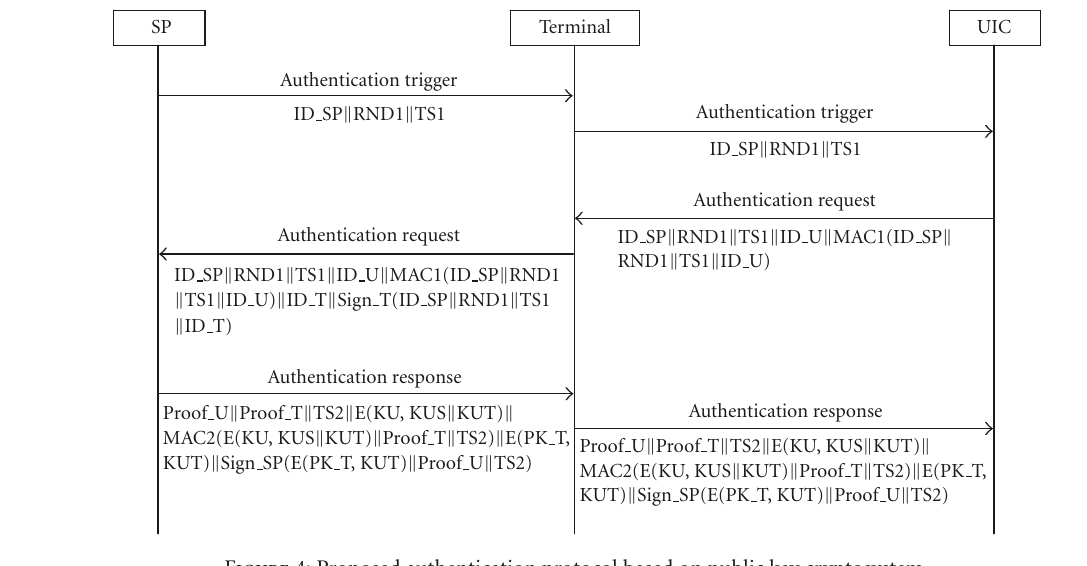
Figure 4: Proposed authentication protocol based on public key cryptosystem.